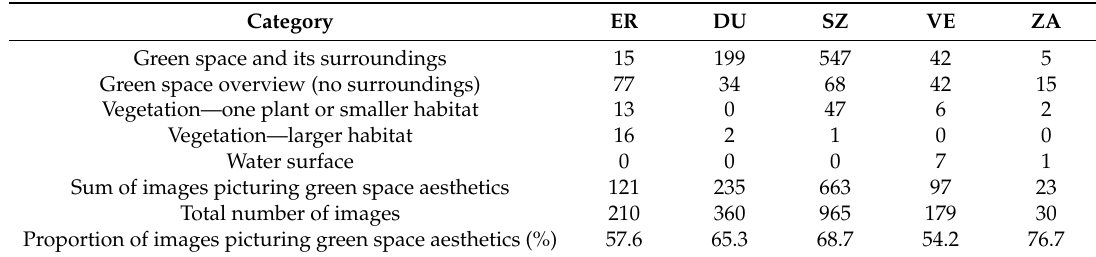
Table 3. Number and proportion of images per UGS picturing green space